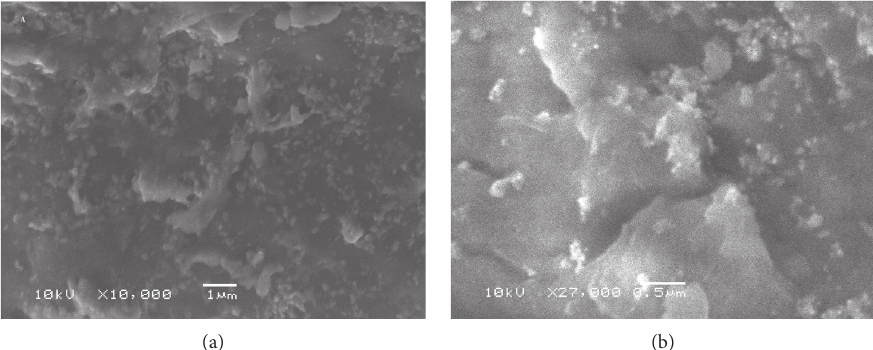
Figure 4: High-resolution electron microscope (SEM) micrograph: (a) silver-Ch-TQ composite using the secondary electron imaging mode (SEI); (b) silver-Ch-TAMPy composite using the secondary electron imaging mode